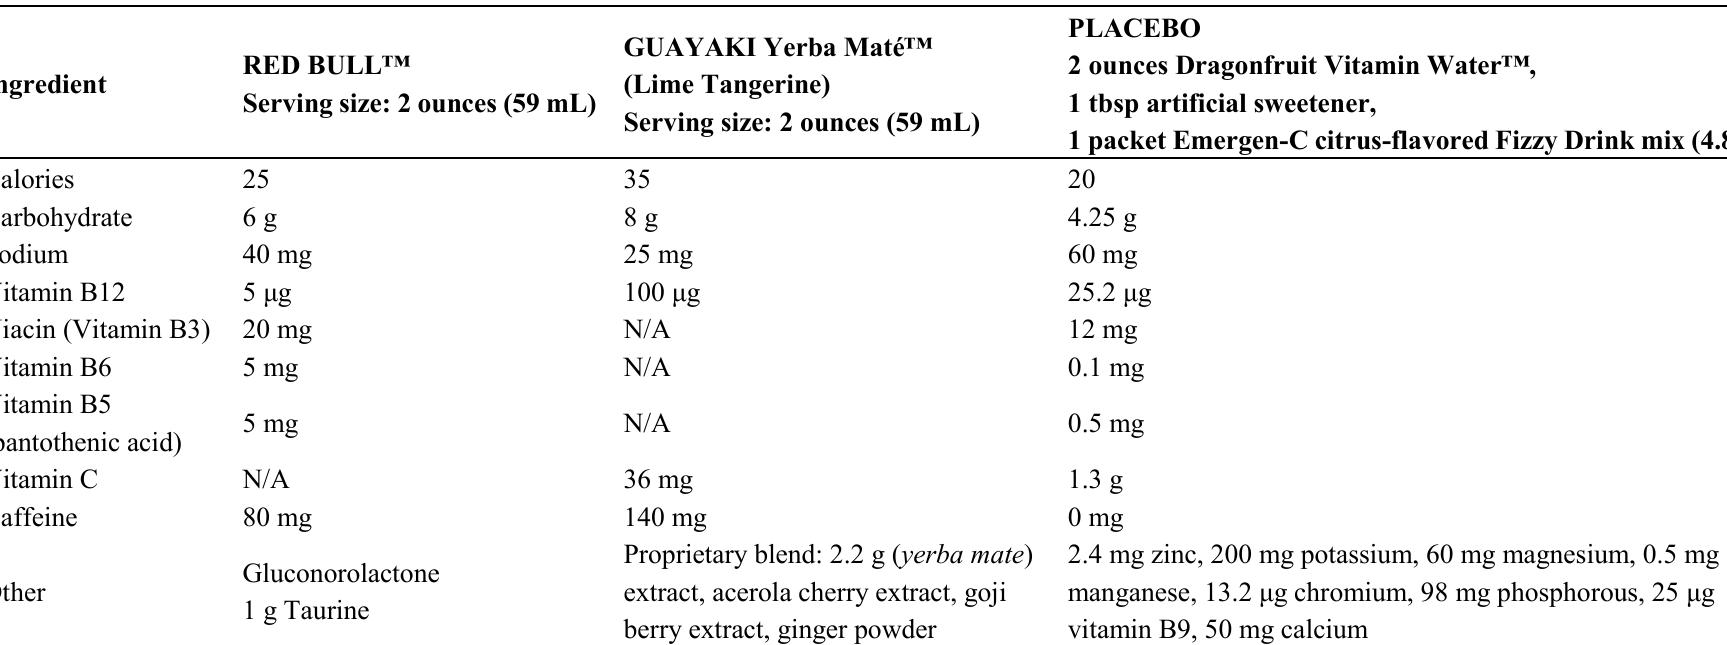
Table 2. Ingredients of beverages per 59 mL serve. PLA = Placebo; YM = Guayakí Yerba Maté; RB = Red Bull.